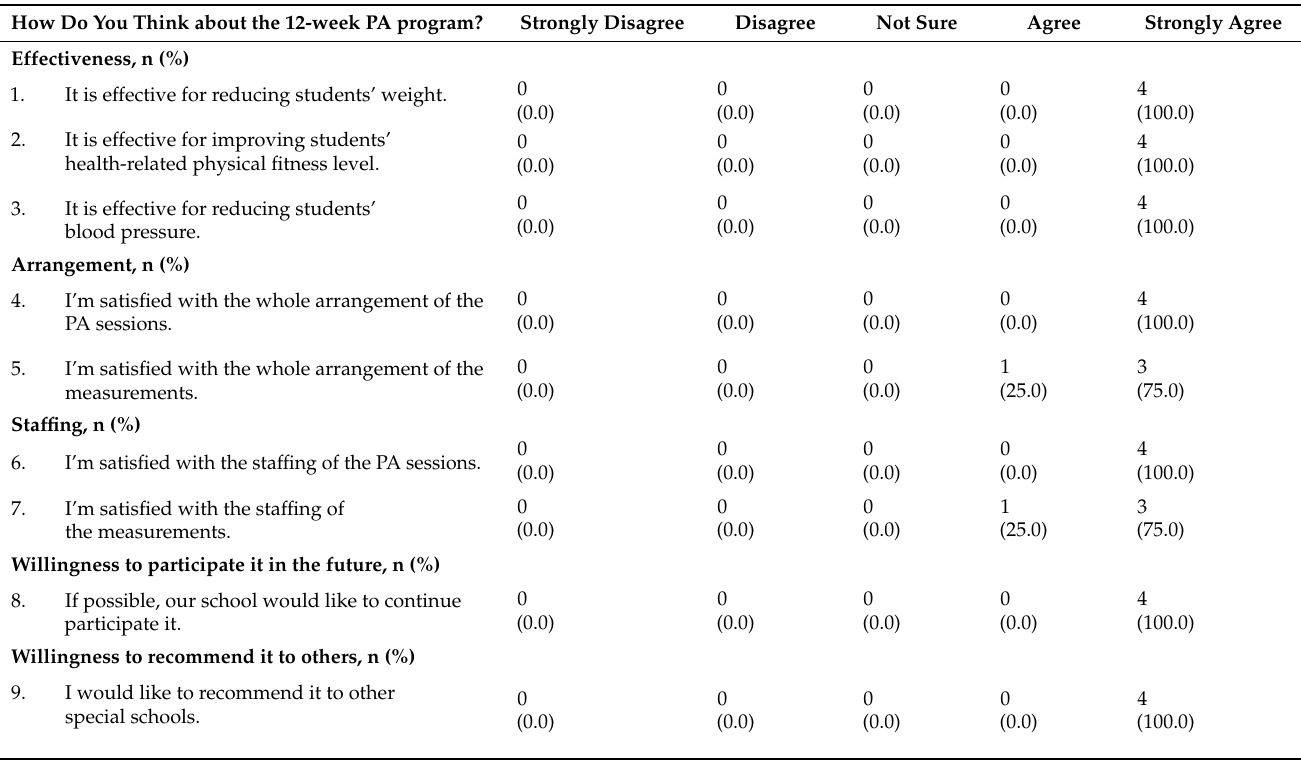
Table A5. Teachers’ feedback on the effectiveness, arrangement, and staffing of the 12-week physical activity programme (n =